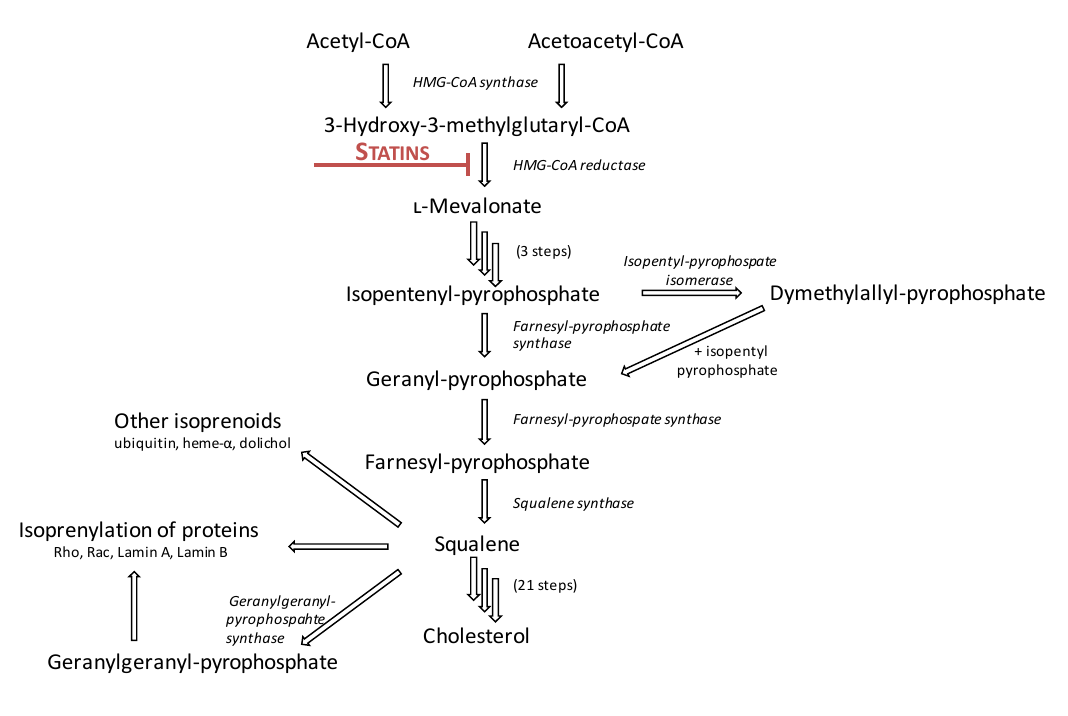
Figure 1. Statins inhibit the conversion of 3-hydroxy-3-methylglutaryl coenzyme A (HMG-CoA) to L -mevalonate, the rate-limiting step of the cholesterol synthesis pathway. Adapted from